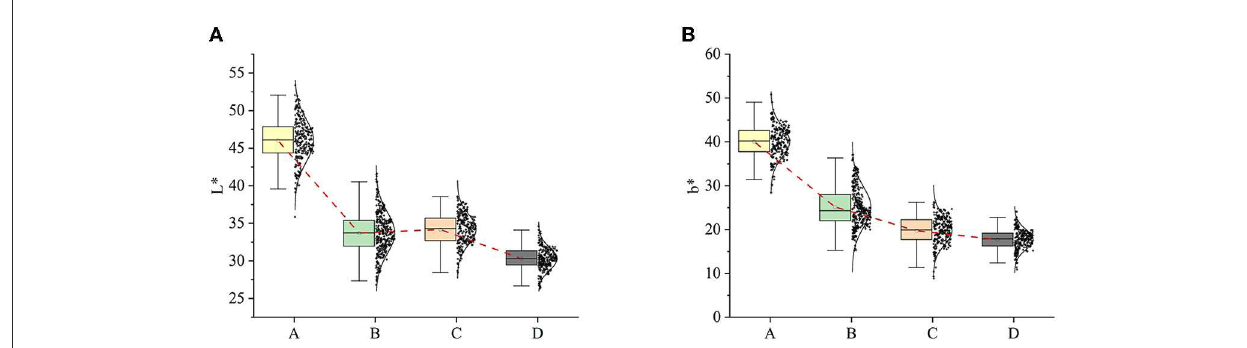
analyzed the relationship between changes in the exterior of hickory nuts kernels and their internal lipid oxidation and rancidity.